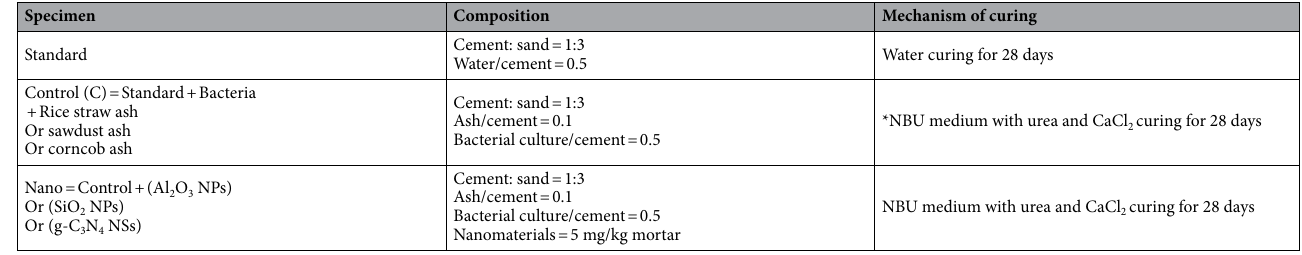
Table 8. Specifications of the specimens. *NBU: nutrient